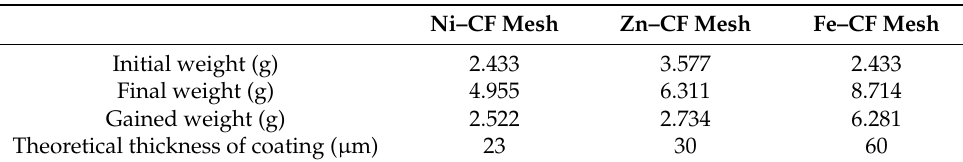
Table 9. Weight gained of metal-coated carbon fiber meshes.